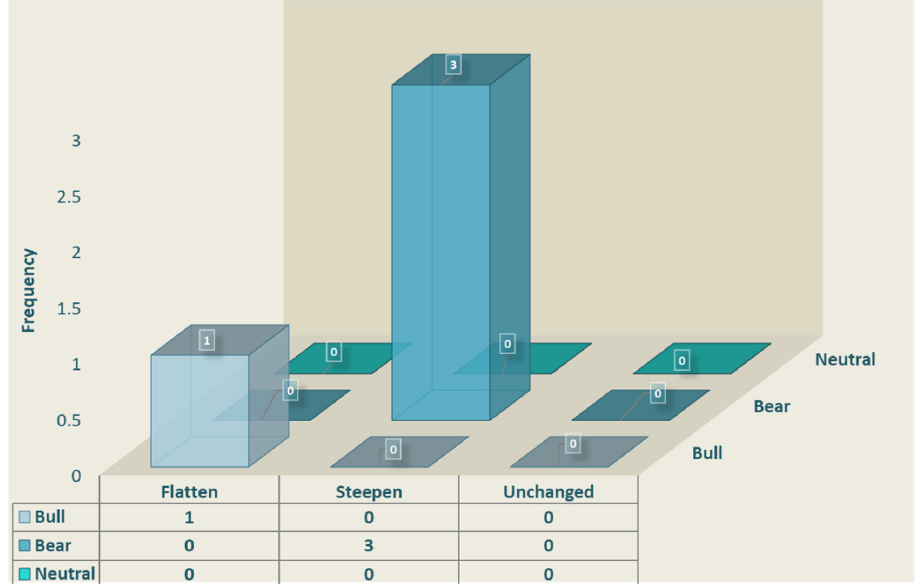
Figure 10. Weekly yield curve patterns on 20 March 2020 (last 4 weeks). Source: Bloomberg yields, own computation of yield curve patterns.